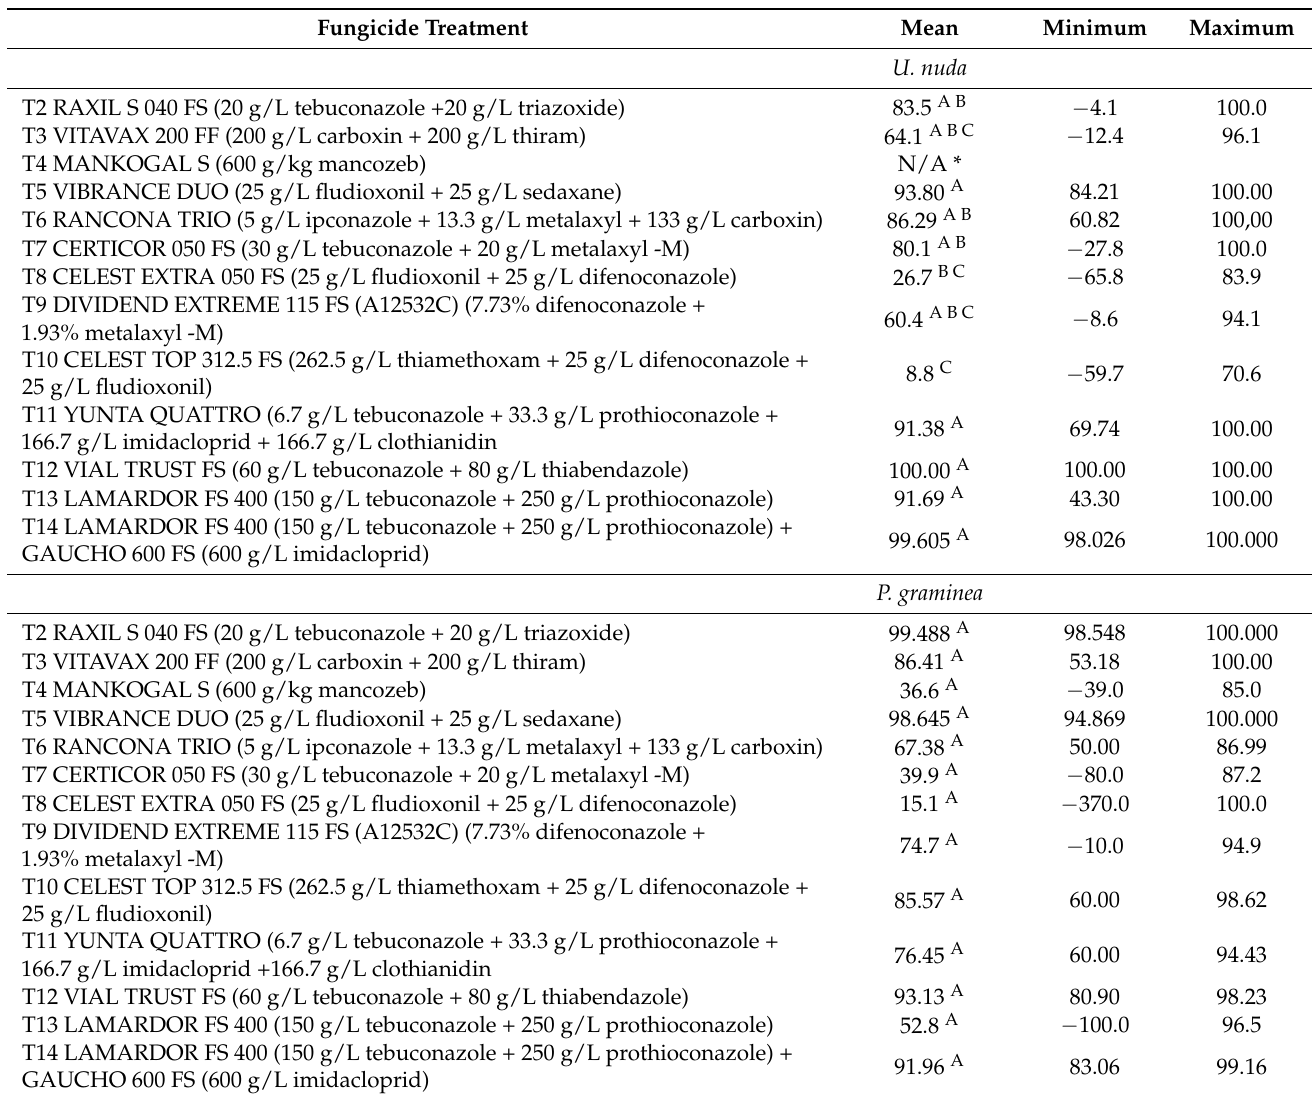
Table 5. Fungicide efficacy against U. nuda and P. graminea in 2014–2020. Fungicide